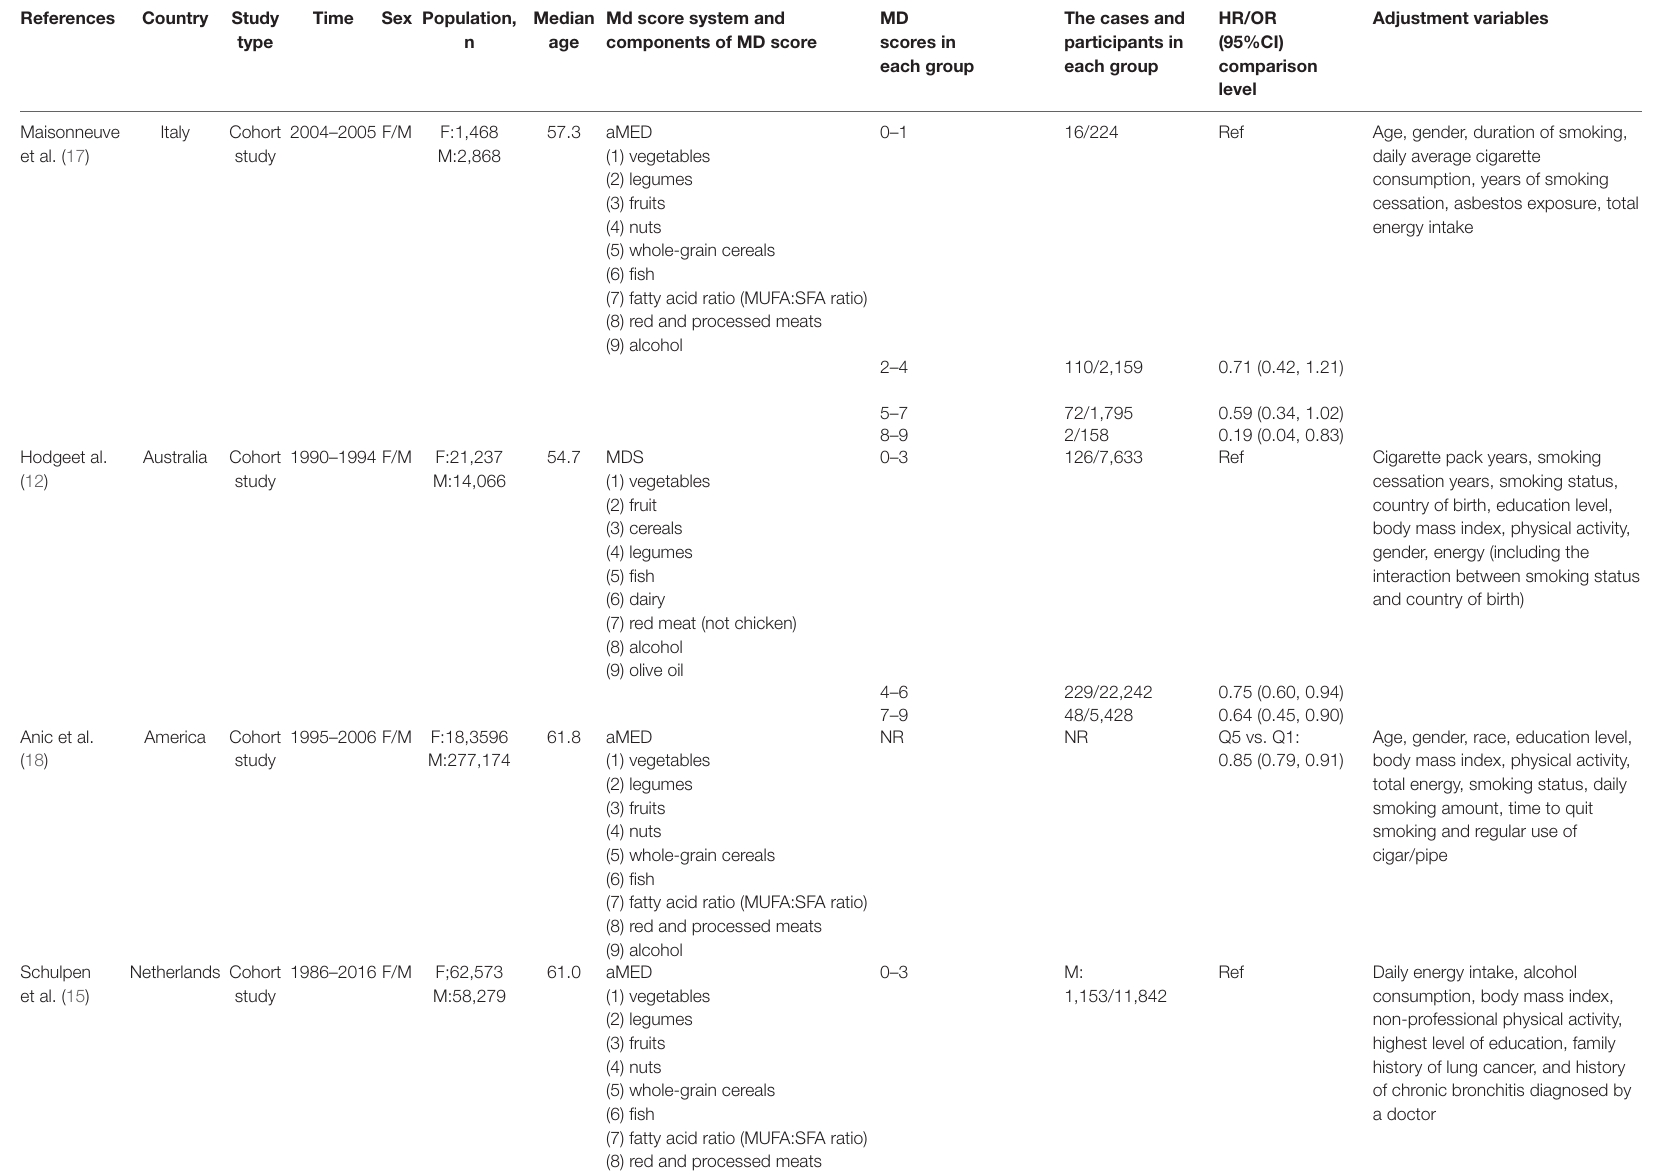
TABLE 1 | Characteristics of studies entered in the